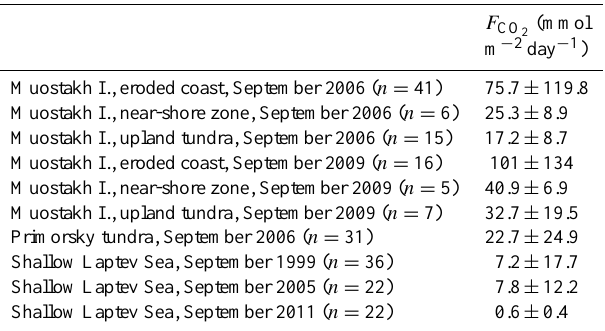
Fig. 16. Distribution of sea–air CO 2 fluxes ( F CO mmolm − 2 day − 1 ) (color code) in the Buor-Khaya Bay ob- served in September 1999 (left panel) and September 2005 (right panel). Table 4. Mean atmospheric CO 2 emission ( F CO Laptev Sea, its eroded coast, and the adjacent